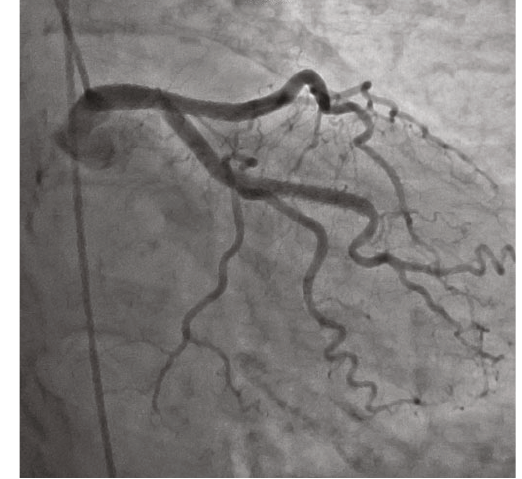
Figure 5: Crossover balloon tamponade of the left femoral artery following removal of the Impella device.